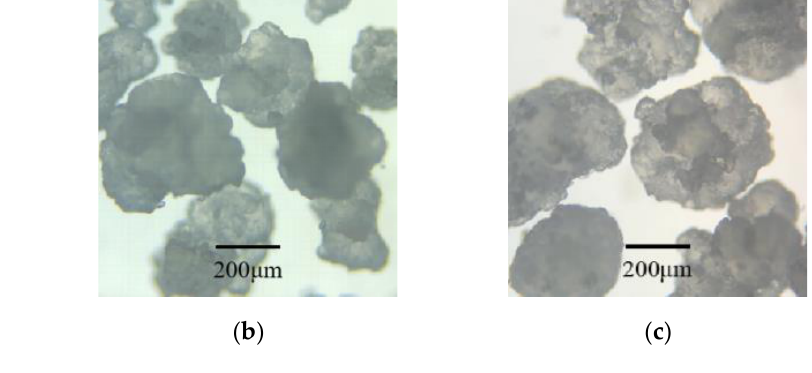
Figure 1. The physical picture of polyethylene particles: ( a ) particle size = 0.3 mm; ( b ) particle size = 0.4 mm; and ( c ) particle size = 0.5 mm.